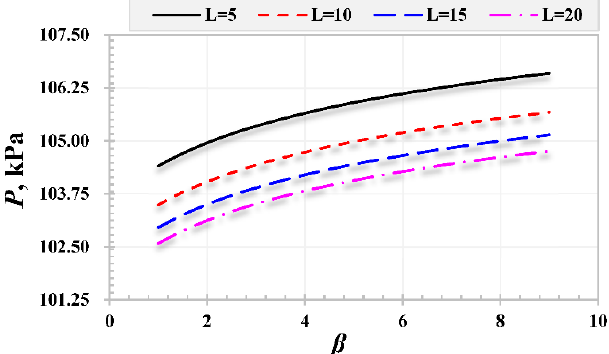
Figure 7. Pressure drop law of coal seam in a single borehole heterogeneous fracturing reservoir.